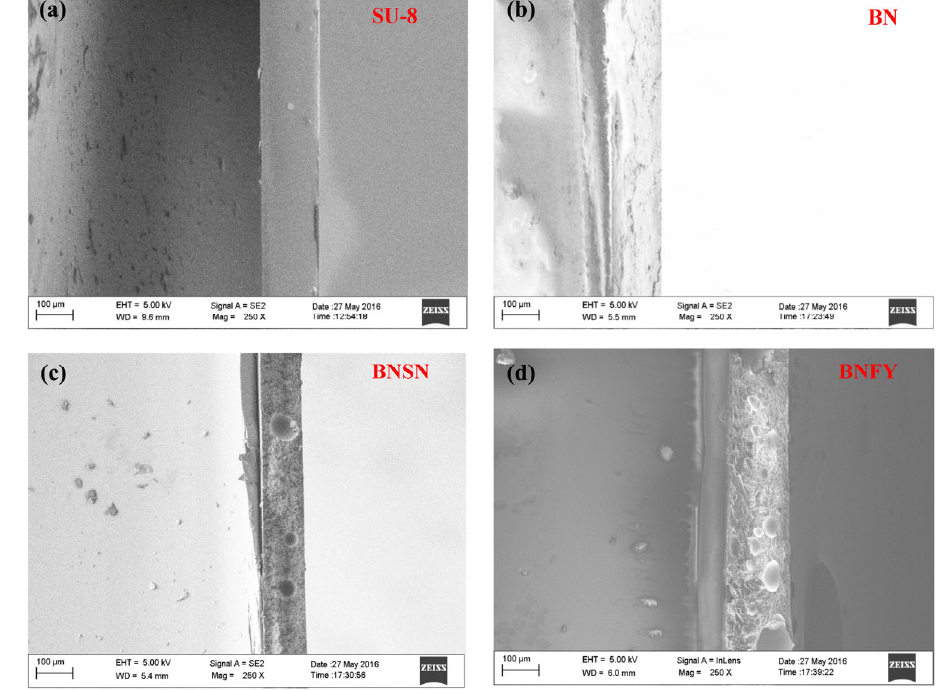
Fig. 3 Cross-sectional images of the composite surface: (a) SU-8, (b) BN, (c) BNSN, and (d)